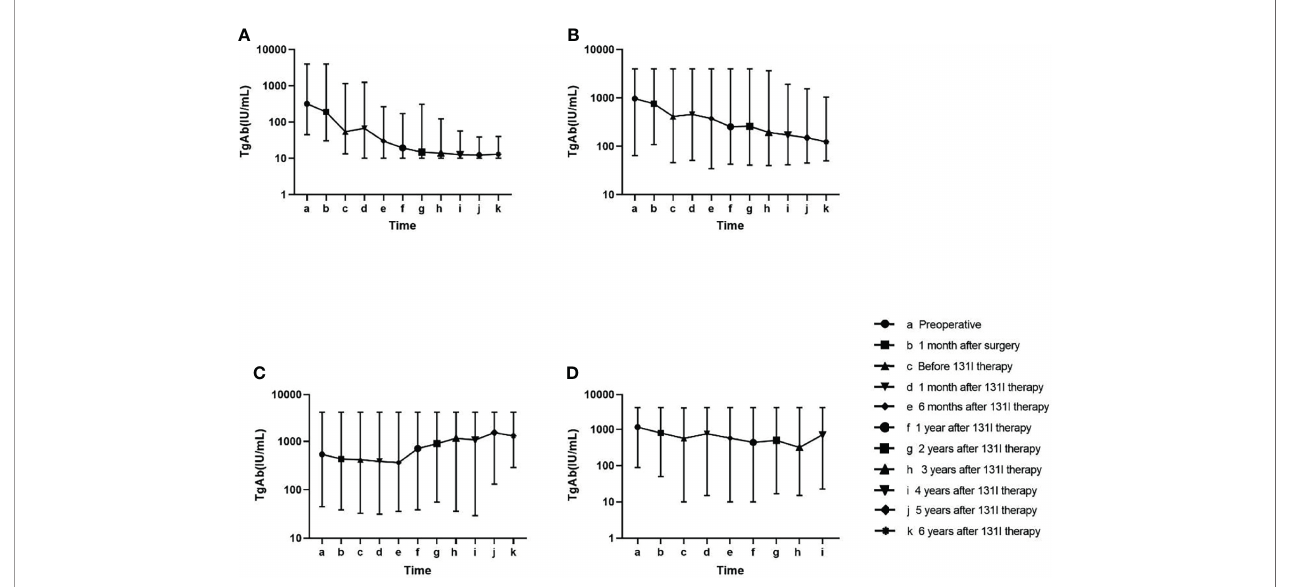
FIGURE 2 | Change in the antithyroglobulin antibody (TgAb) level in the follow-up of four groups. Patients in Group (A) had lower TgAb concentrations than the other three groups at every time point in the follow-up (p < 0.05). Patients in Group (B) had lower TgAb concentrations than those in Group (C) at the late follow-up (p < 0.05). No signi fi cant difference was found in the TgAb values at other time points among Groups (B – D) ( Table 2